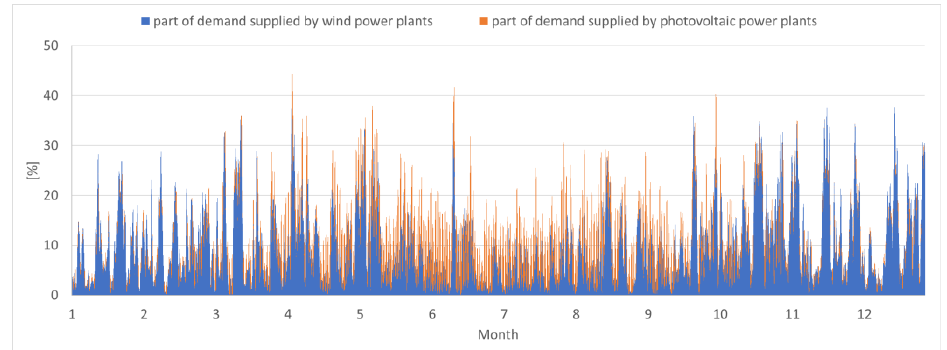
Figure 5. Coverage of demand for power by photovoltaic and wind power plants in Poland in 2021 (own compilation of data from PSE S.A.).